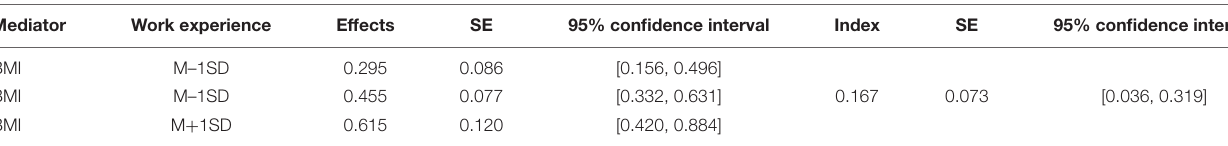
FIGURE 2 | Interactive effect of founders creativity and work experience on business model innovation. TABLE 5 | Results of moderated mediating effect